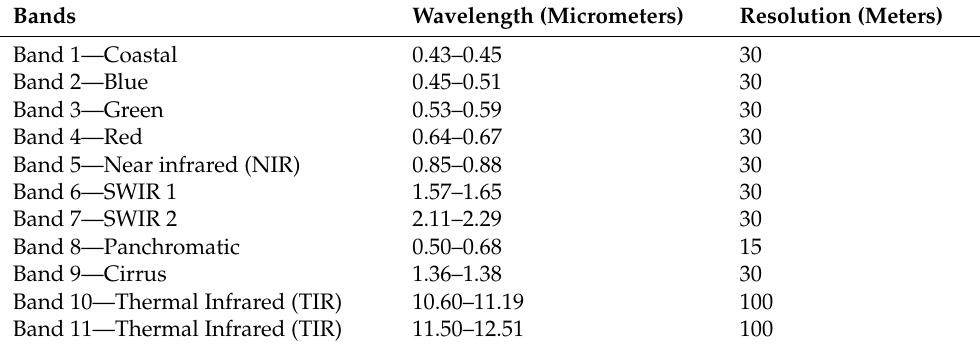
Table 1. Landsat 8 bands technical